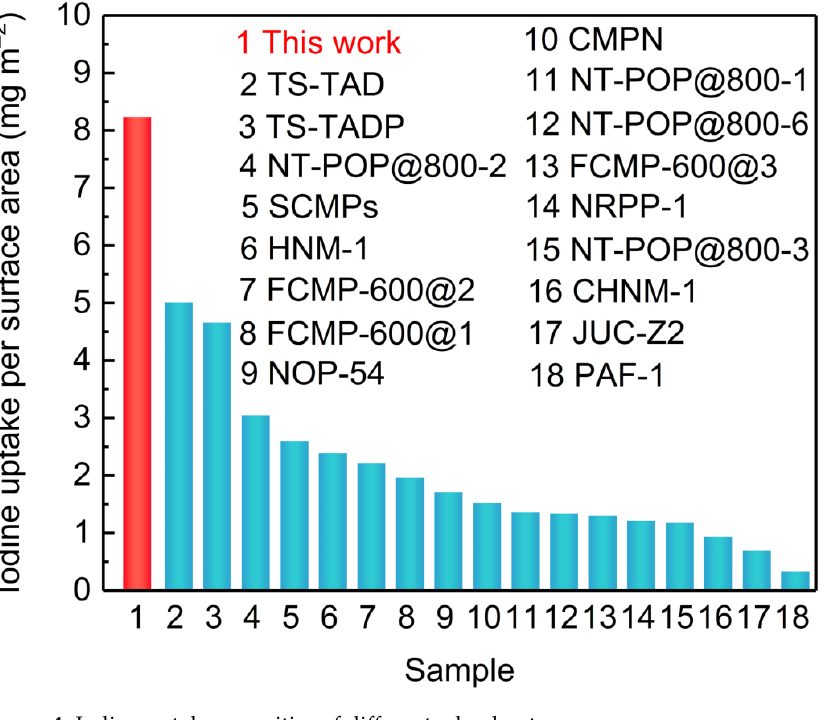
Figure 4. Iodine uptake capacities of different adsorbents.